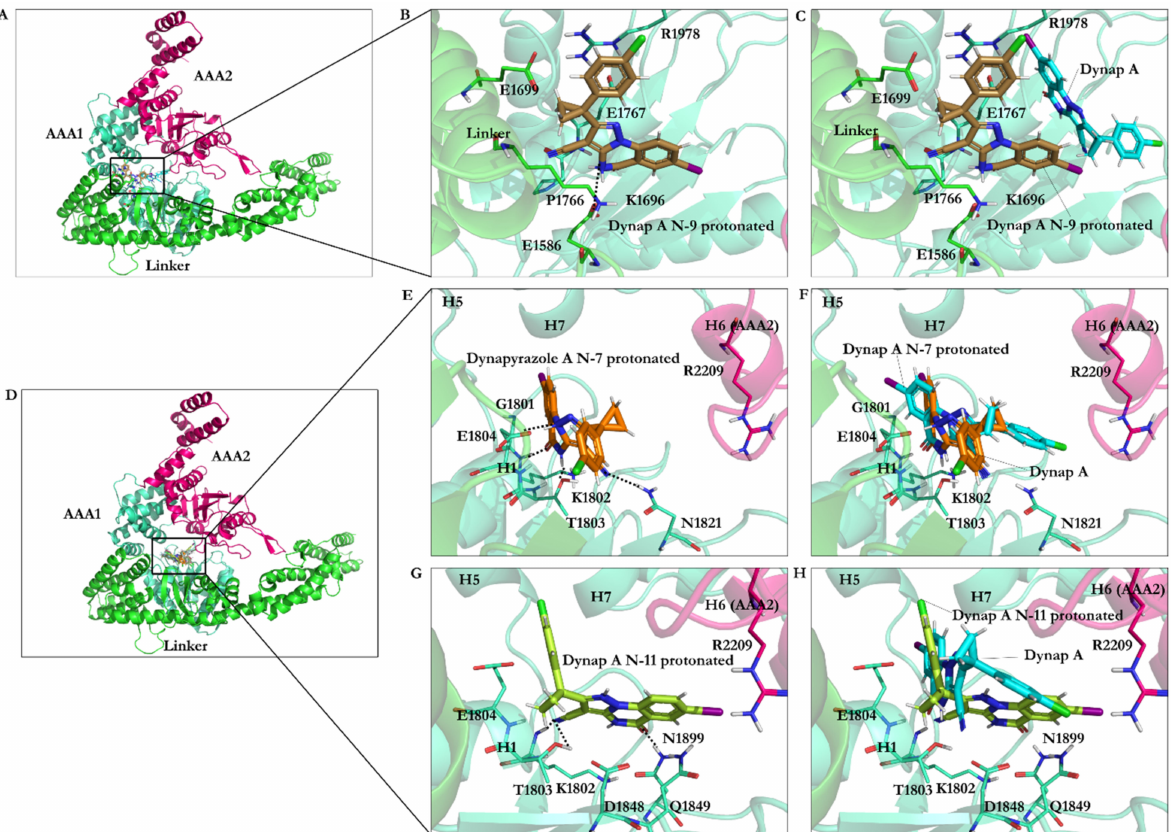
Figure 13. Binding of the protonated dynapyrazole A at the AAA1 binding site of dynein 1. ( A ) Overview of the AAA1 and AAA2 units, and linker domains. ( B ) Dynapyrazole A protonated at the N9 atom interacting with the linker residues. ( C ) Dynapyrazole A protonated at the N9 atom superimposed on dynapyrazole A. ( D ) Overview of the AAA1 and AAA2 units, and linker subdomains (as the panel A). ( E ) Dynapyrazole A protonated at the N7 atom. ( F ) Dynapyra- zole A protonated at the N7 atom superimposed on dynapyrazole A. ( G ) Dynapyrazole A protonated at the N11 atom. ( H ) Dynapyrazole A protonated at the N11 atom superimposed on dynapyrazole